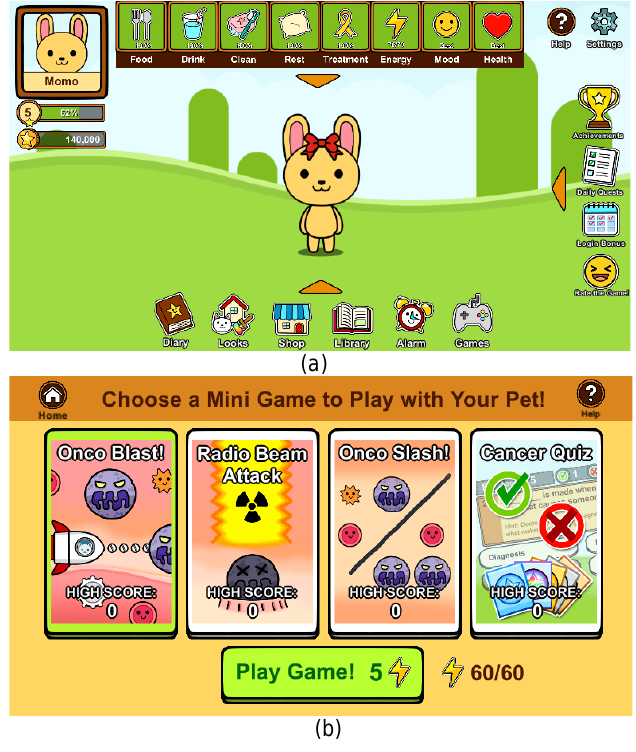
Figure 1. Screenshots from Pets vs Onco, (a) Home Screen where a player can access all the game modules, and (b) Mini Game Selection